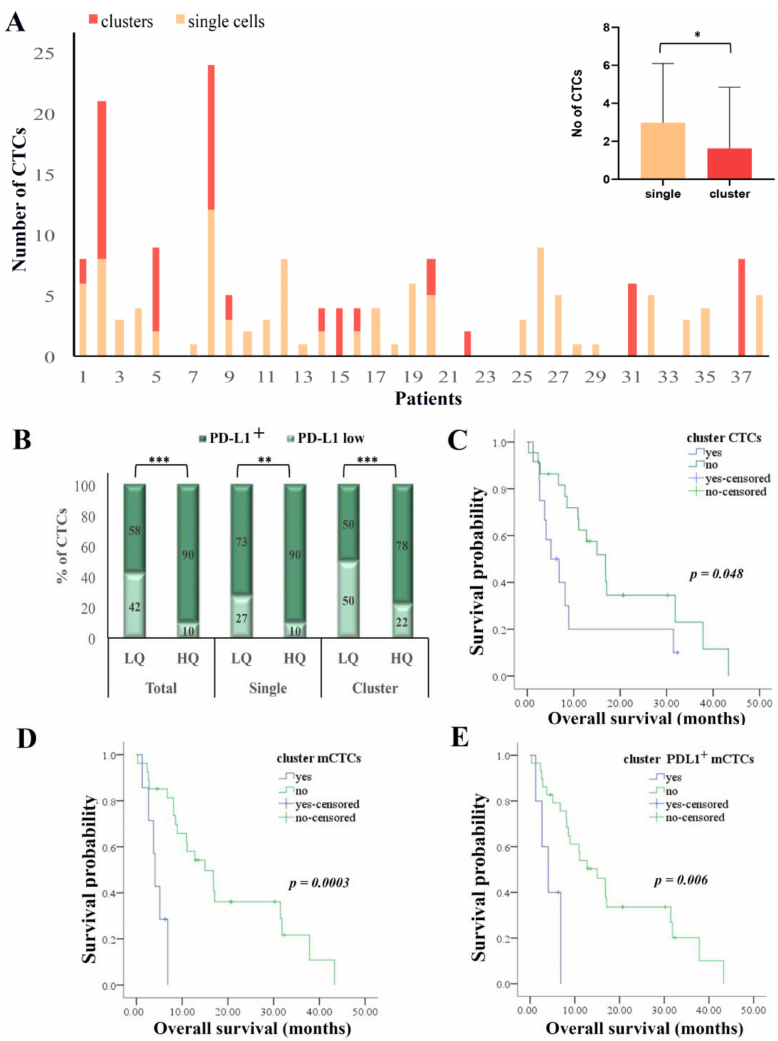
Figure 2. Detection and clinical significance of single and cluster subpopulations of CTCs. ( A ) Distribution of single and cluster CTCs in patients ( n = 38). The number of CTCs per patient detected in all metastatic breast cancer patients is presented. Inset shows mean values of CTCs detected either as single cells or in clusters. * wilcoxon test; statistical significance at p = 0.037. ( B ) Frequency of PD-L1 expression (PD-L1 + ) in total, single and cluster CTCs within the low quartile (LQ) and the high quartile (HQ) of vim / ker ratios. Chi square test; statistical significance ** p = 0.032, *** p ≤ 0.001. ( C – E ) Kaplan-Meier analysis of overall survival (OS) according to the presence or not of cluster CTCs ( C ), cluster mCTCs ( D ) and cluster PD-L1 + mCTCs ( E